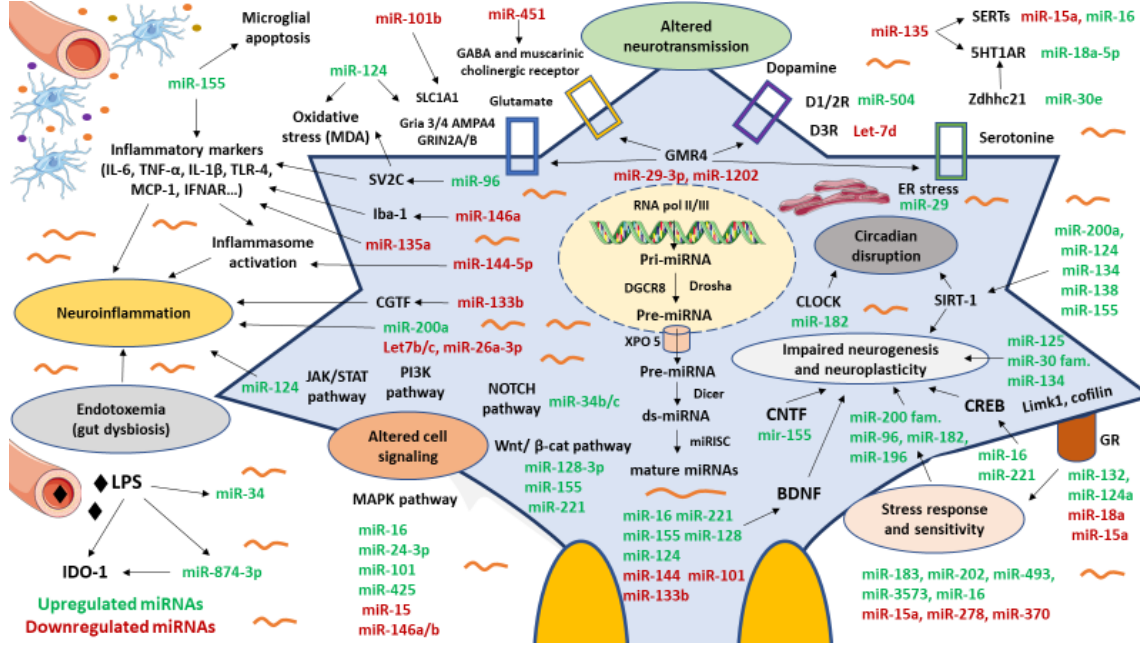
Figure 2. A general picture of the molecular background of miRNAs in MDD. As showed, there are multiple pathways affected by the dysregulation of a set of miRNAs in this mental disorder. Some of their molecular targets are involved in critical pathophysiological mechanisms of MDD, and either the upregulation (represented in green) or downregulation (In red) may be partly responsible for the changes in the neurons and glial cells of depressed individuals. Some of these alterations have been reported in critical areas of the brain such as the amygdala or the hippocampus, clearly implicated in the etiopathogenesis of MDD. Finally, there are some miRNAs that may be regulated by the exposure to the pathological environment including after acute or prolonged stress or due to the endotoxemia and